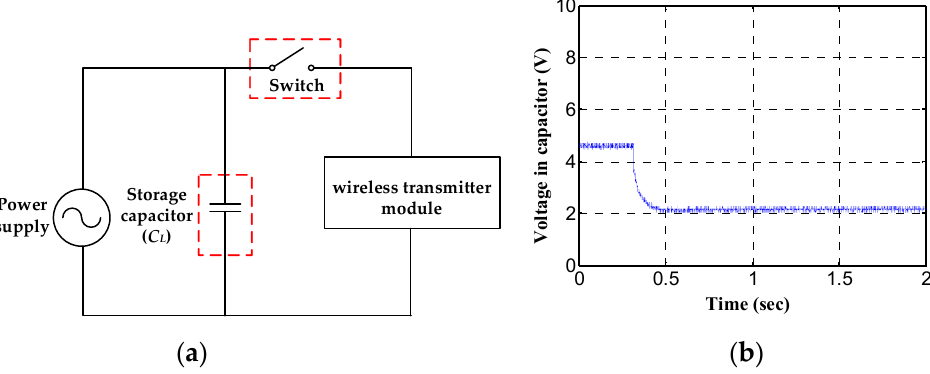
Figure 12. Measurement of driven condition for wireless transmitter module; ( a ) Designed testing electric circuit to obtain driven power and storage capacitor determination; ( b ) Testing result of voltage variation in storage capacitor.